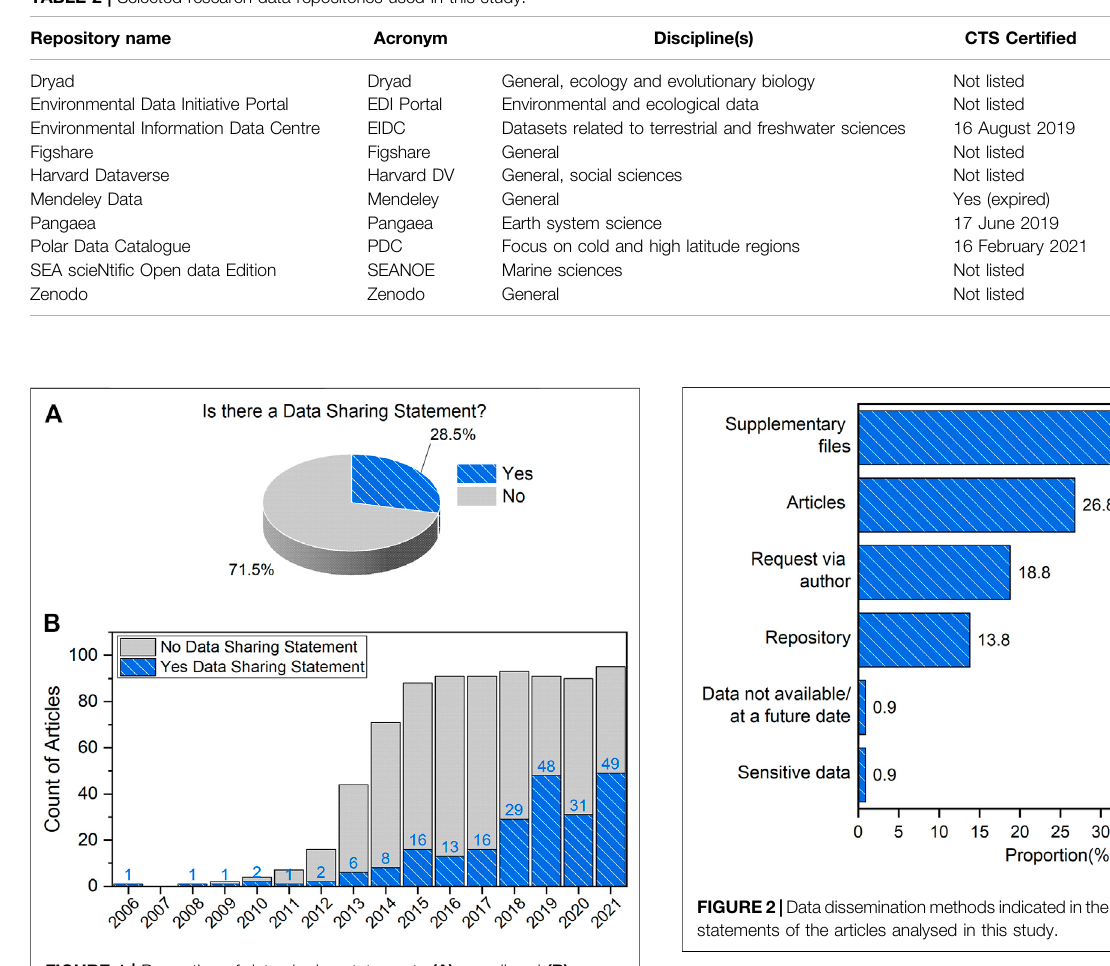
FIGURE 1 | Proportion of data sharing statements (A) overall and (B) annuallybetween2006and2021inthepeer-reviewed publications.Numbers displayed on the bars in panel b refer to the yearly number of data sharing statements.